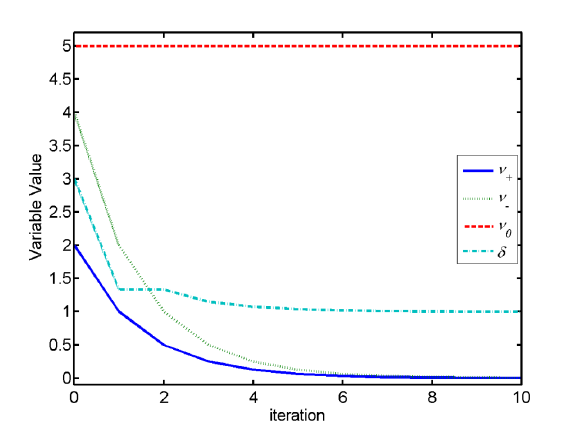
Figure 2. A plot showing the convergence of the Heaviside function MPCC when x = 0. As the plot shows, δ converges to 1 as